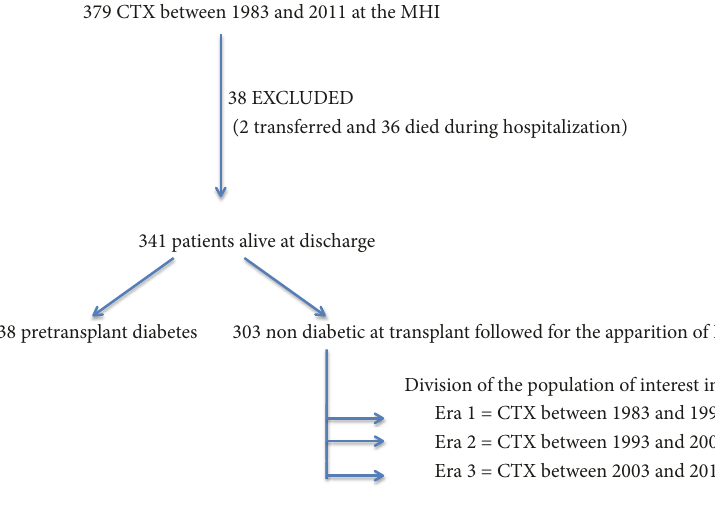
Figure 1: Flowchart of the study and division era.